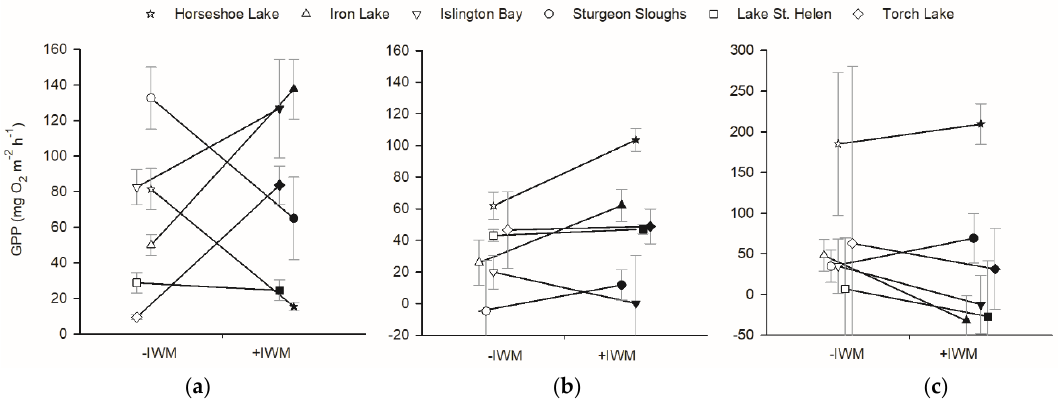
Figure 4. Gross primary production (GPP) measured in light-dark bottles, and scaled per plot area of ( a ) epiphyte, ( b ) phytoplankton, and ( c ) benthic periphyton. Means ± 1 standard error are represented by symbols with error bars. Shaded symbols represent +IWM plots, and unshaded symbols represent − IWM plots for each waterbody. Lines connecting symbols illustrate differences in paired plots. Symbols are offset horizontally to aid in interpretation of error bars.